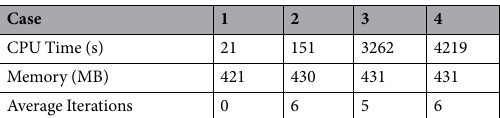
Table 2. Computational statistics of the proposed